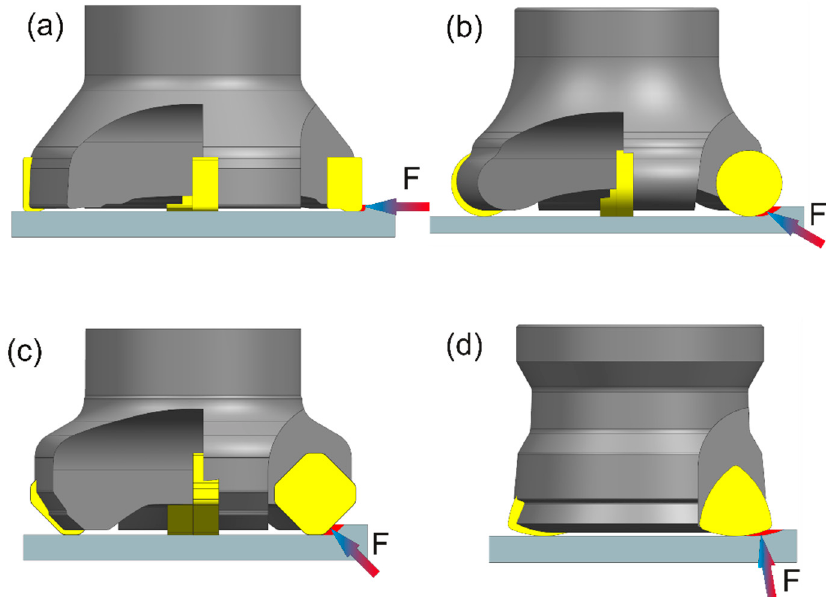
Figure 1. Cutting force directions for various face milling cutter types: ( a ) entering angle of 90°, ( b ) round insert, ( c ) entering angle of 45°, ( d ) entering angle of 10°–20°.